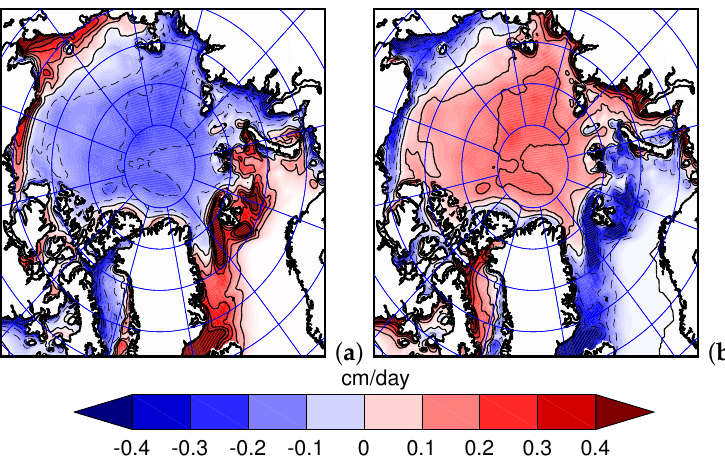
Figure 4. Ice growth rate (cm/day) averaged over the period 1948-2019 due to ( a ) dynamic factors, ( b ) thermodynamics of freezing and melting. (Latitudes: interval—5 degrees, maximum is 85 N. Longitudes: interval—30